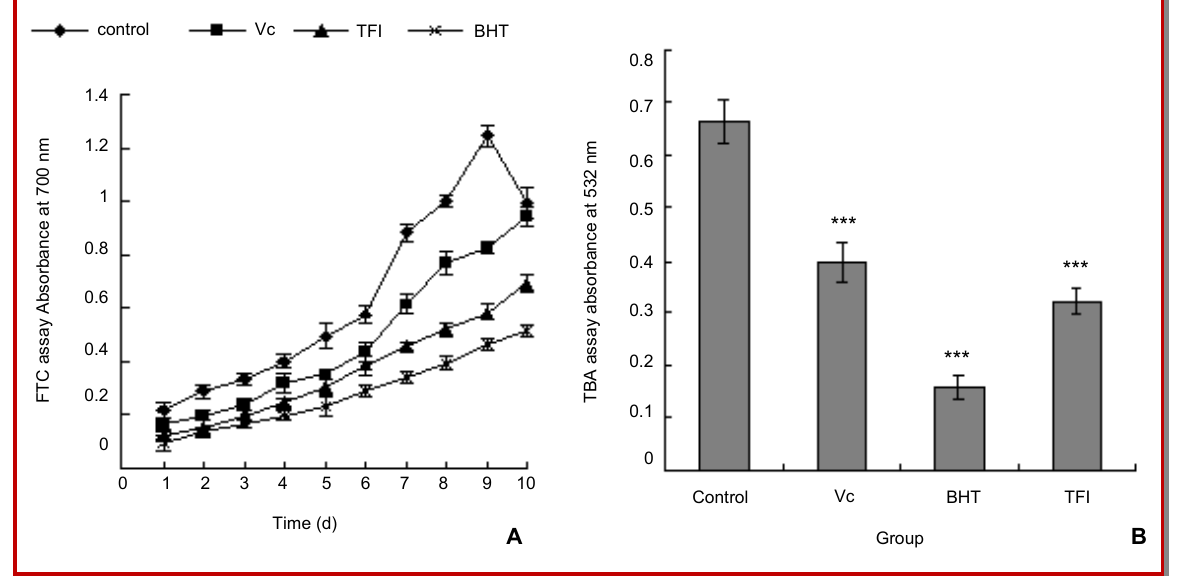
Figure 3: Antioxidant activities of total flavonoids of I. latifoliu assayed using the A) FTC and B) TBA methods. Low absorbance values indicate a strong antioxidant activity. All of the samples were measured at the same concentration of 0.1 mg/mL of total flavonoids of I. latifoliu . Statistically significant differences have been indicated by asterisks (***p<0.001 compared with the